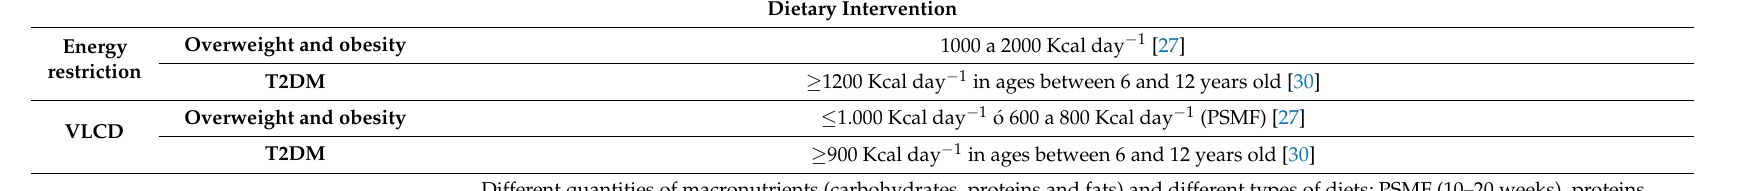
Table 4. Intervention strategies for the reduction of body composition in overweight, obesity and T2DM: children and adolescents. Dietary Intervention